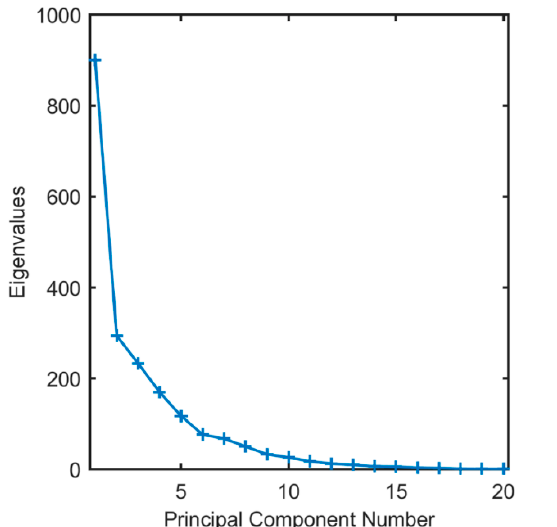
Figure A3. Scree plot showing decreasing eigenvalues as number of PCs increase. A “knee” occurs at PC6.